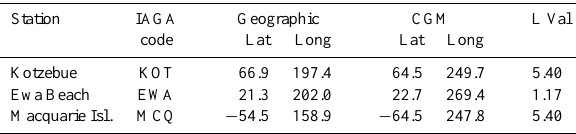
Table 3. Location of 250 ◦ magnetometer